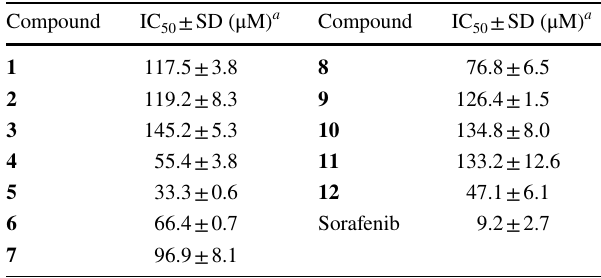
a Data were expressed as means ± SD ( n = 3) from three